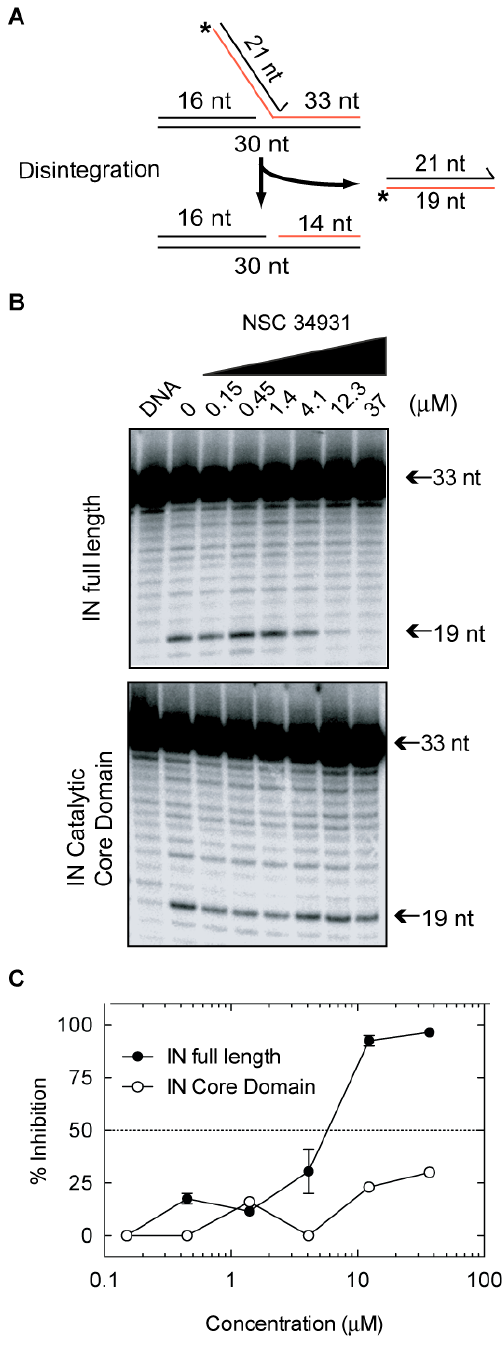
Figure 3. Inhibition of the disintegration reaction by NSC34931. ( A ) Schematic representation of the disintegration reaction. The length of each oligonucleotide is indicated (nt = nucleotide) ( B ) Representative PAGE image of the inhibition of disintegration by NSC34931 on full-length IN (top) or the isolated catalytic core domain (bottom). ( C ) Densitometric analysis of the gel pictures presented in B. Data represent mean ± SD from at least three independent experiments.